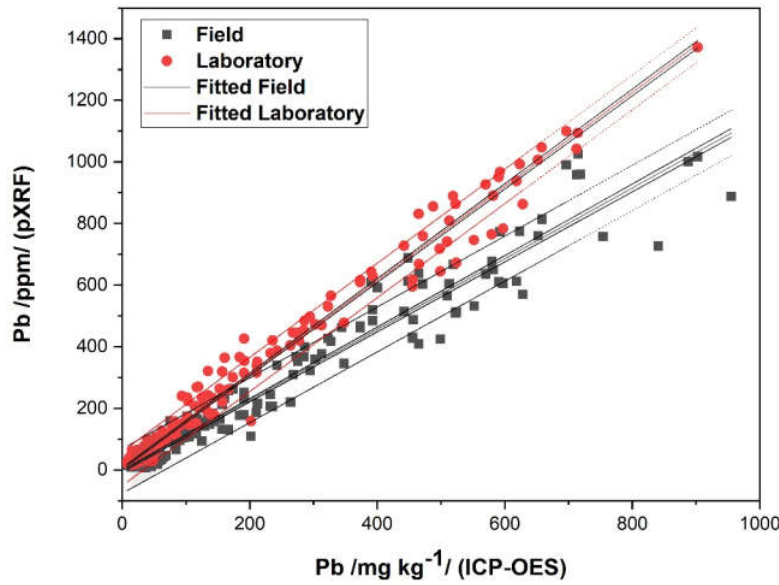
Figure 5. Statistical significance of regression model for Lead (pXRF) in soil samples from experimental soil sites from Otava and Mže river basins, measured in FIELD and LABORATORY.